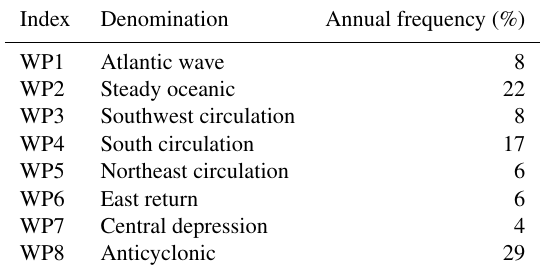
Table 3. Names of the weather patterns (WP) defined in Garavaglia et al. (2010) and the related frequency for the 1982–2001